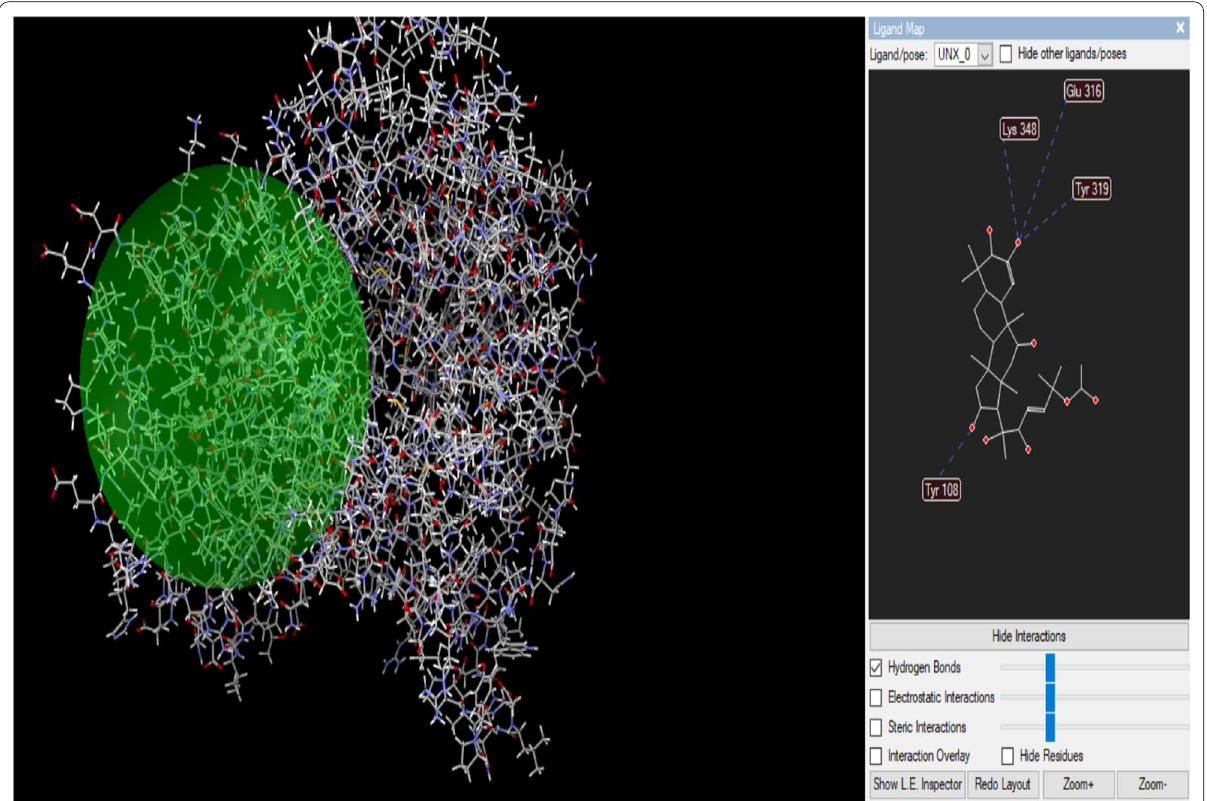
Fig. 16 The 3D representation of Cucurbitacin E at the active site of G. mellonella GPx enzyme (Hydrogen bonds; Lys 348; Glu 316; Tyr 319; Tyr 108)